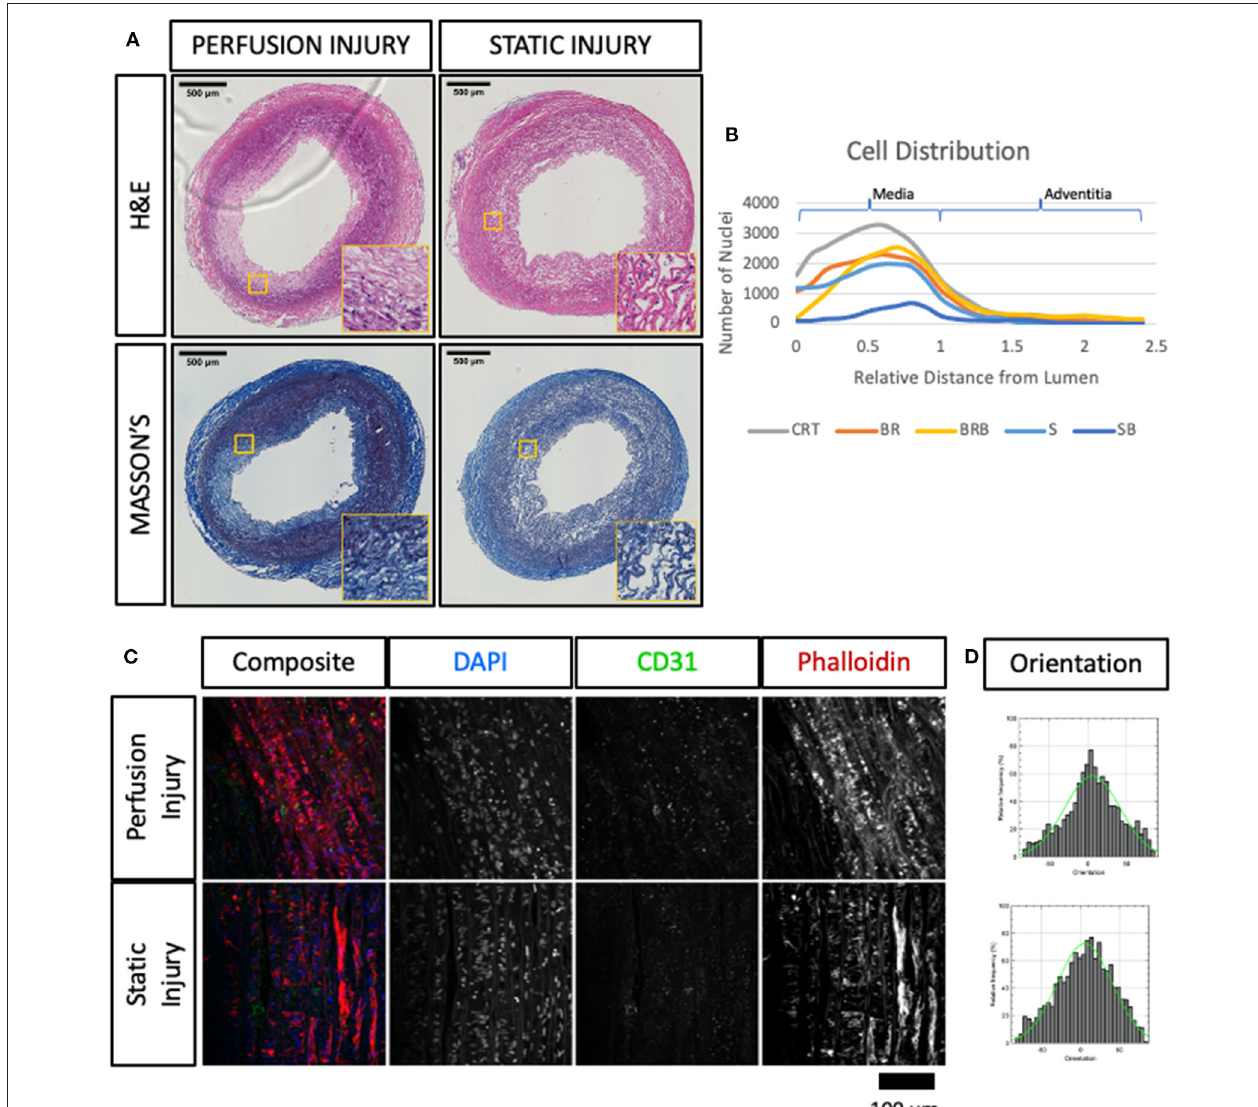
FIGURE 5 | Immuno-histological evaluation of angioplastied carotid arteries after culture reveal functional and structural damage. Injured vessels were cultured in EasyFlow (Perfusion Injury) or in static conditions (Static Injury) for 7 days and analyzed by Hematoxylin and Eosin staining (H&E) and Masson’s Trichomic staining (MASSON’S) (A) . Scale bars = 500 µ m. Distribution of DAPI + nuclei across the vessel wall is quantified in freshly isolated arteries (CRT), healthy and injured arteries cultured for 7 days in EasyFlow (BR and BRB, respectively) or static conditions (S and SB, respectively) (B) . En-Face representative images showing endothelial coverage (CD31), stress fiber (Phalloidin), and nuclei (DAPI) in samples cultured for 7 days in perfusion or static after injury (C) . Fiber alignment is quantified as vector distribution and plotted in histogram representing the relative frequency (y) against the angle (x), where zero is perpendicular to the flow direction (Orientation). An ideal normal distribution of values is represented in green over the histogram (D) . Scalebar = 100 µ m.